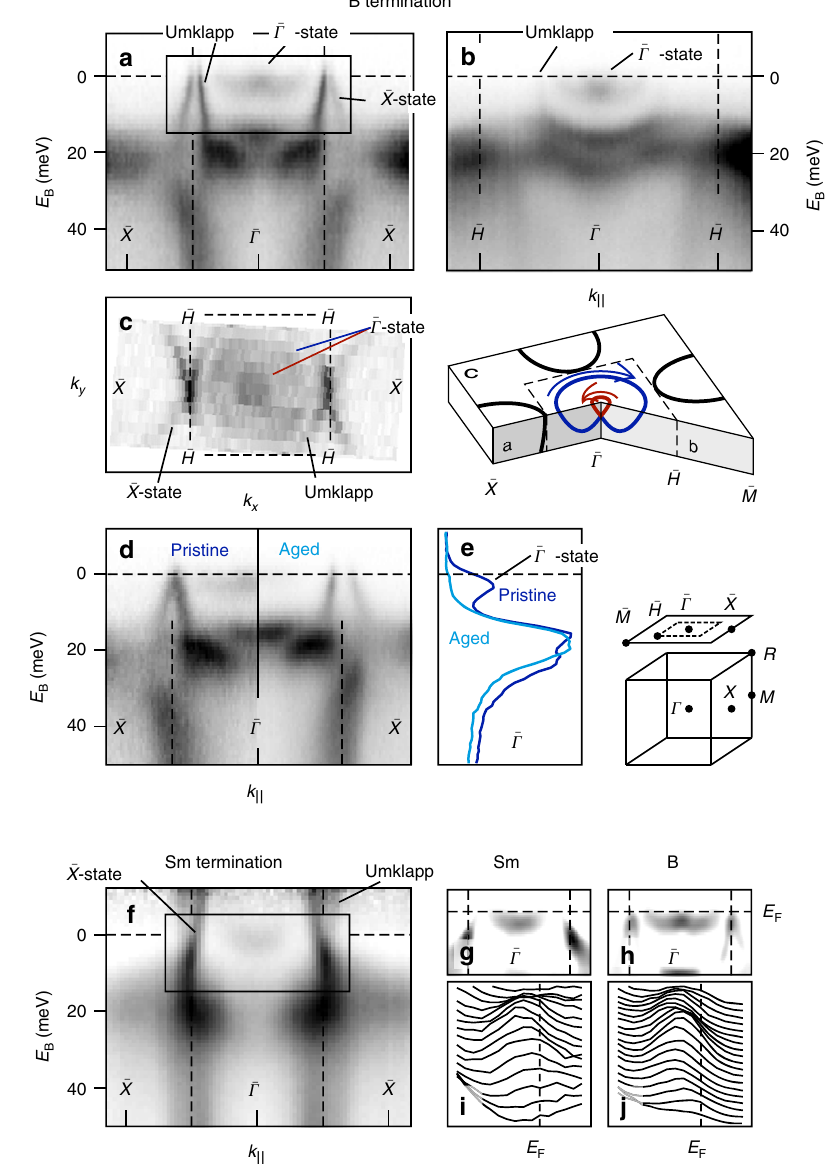
Fig. 1 Massive nature of the Γ state. Photoemission intensity ( I ) along a Γ − X and b Γ − M for the B-terminated surface. c The Fermi surface for B termination. d Photoemission intensity along Γ – X on a pristine and aged B-terminated surface. e Photoemission spectra at Γ of the pristine (blue) and aged (light blue) surface. f Photoemission intensity along Γ – X on a Sm-terminated sample. Data in f , g , i obtained at 40 K to populate a larger fraction of the shallow Γ state. Results have been divided by a Fermi-Dirac distribution. g , h Second derivative (d 2 I /d E 2 ) of the photoemission intensity in the rectangular areas marked in f , a . i , j Γ state represented as spectra for Sm and B termination. h ν = 31 eV, s